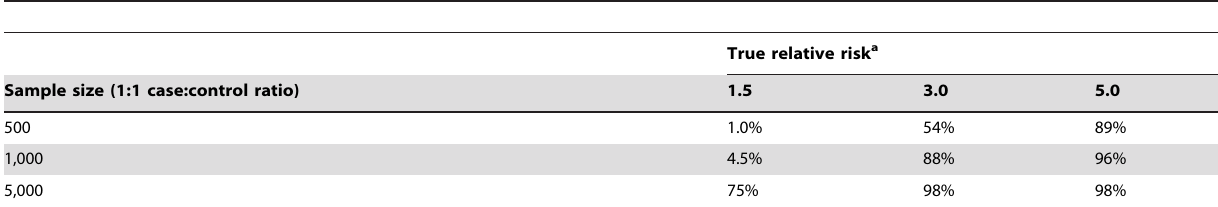
Table 3. Average study power to detect associations between metabolites and disease in a case-control study according to different relative risks and sample